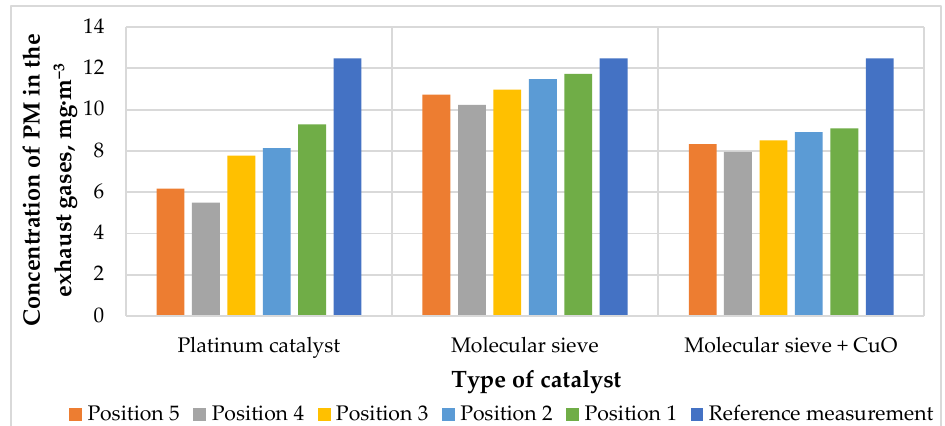
Figure 8. PM concentration in exhaust gases depending on the type and location of the catalyst. During the combustion of landfill gas in a flare without the use of catalysts, the average PM concentration was 12.5 mg·m −3 . After installing the platinum catalyst, the PM concentration in the exhaust gases decreased on average in the range of 3–4.7 mg·m −3 . It can be seen that the greatest degree of PM reduction was recorded in the fourth position of the catalyst location. The flare with the installed catalyst in the form of a molecular sieve bed emitted exhaust gases with a lower PM concentration in the range of 0.7–2.2 mg·m −3 . A catalyst based on a molecular sieve with a layer of CuO caused a decrease in PM concentration in the exhaust gases in the range of 3.3–4.5 mg·m −3 .